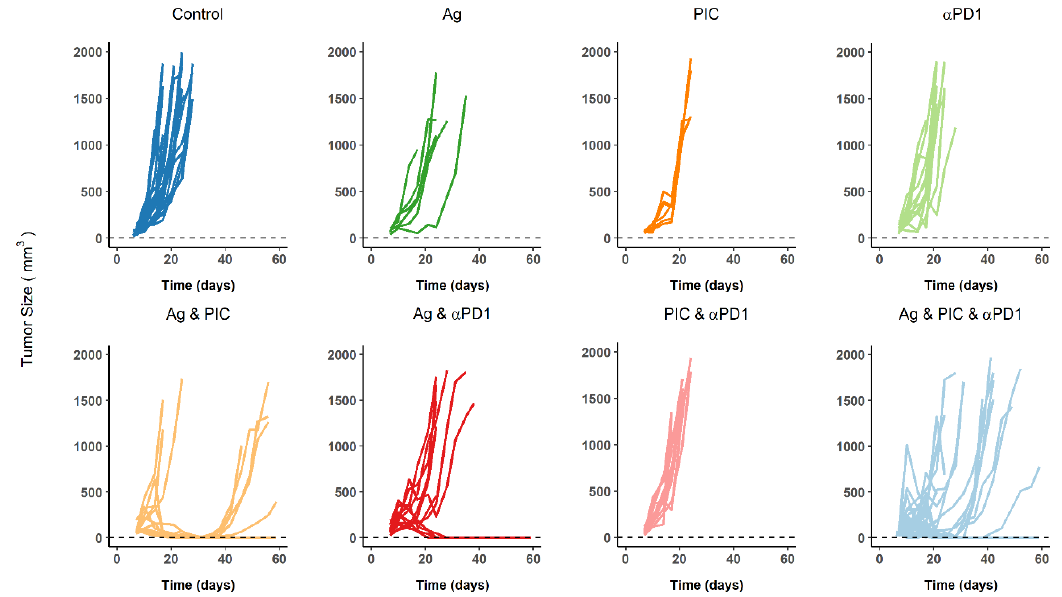
Figure 1. Individual raw data profiles. Tumor size over time, computed as volume based on two perpendicular diameters, is represented for each mouse and each treatment group included in the analysis. Horizontal dashed lines represent the lower limit of quantification (4 mm 3 ).